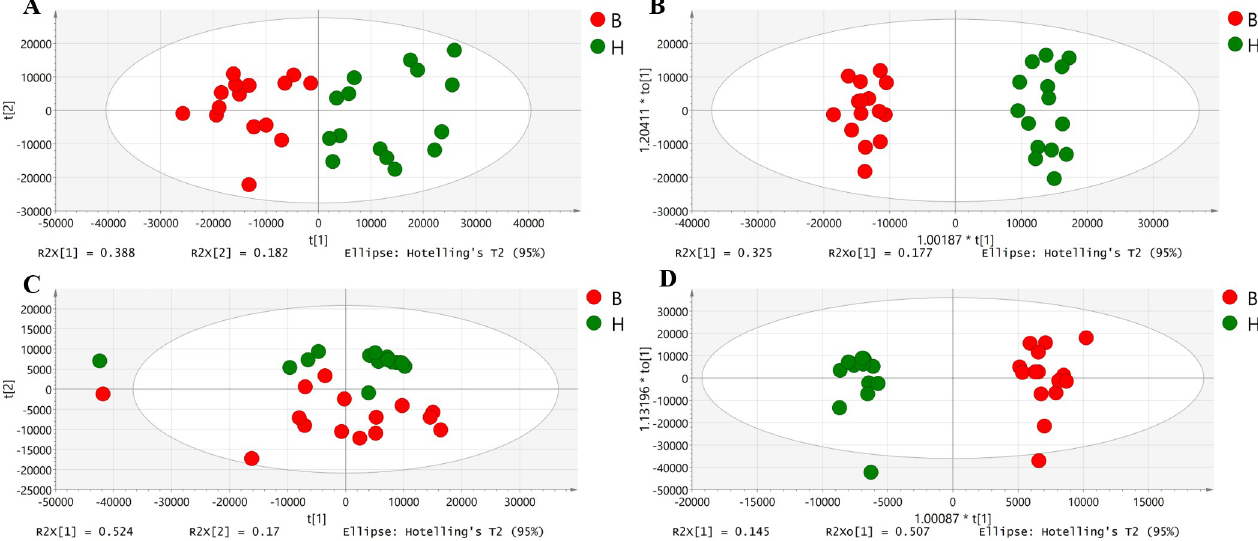
Fig 1. PCA (A and B, in positive and negative modes, respectively) and OPLS-DA (C and D, positive and negative modes, respectively) scores plots of Italian Mediterranean buffaloes’ milk and Chinese Holstein cows’ milk. The red circle represents buffaloes, while the green circle represents cows. PCA = principal component analysis. OPLS-DA = orthogonal partial least squares discriminant